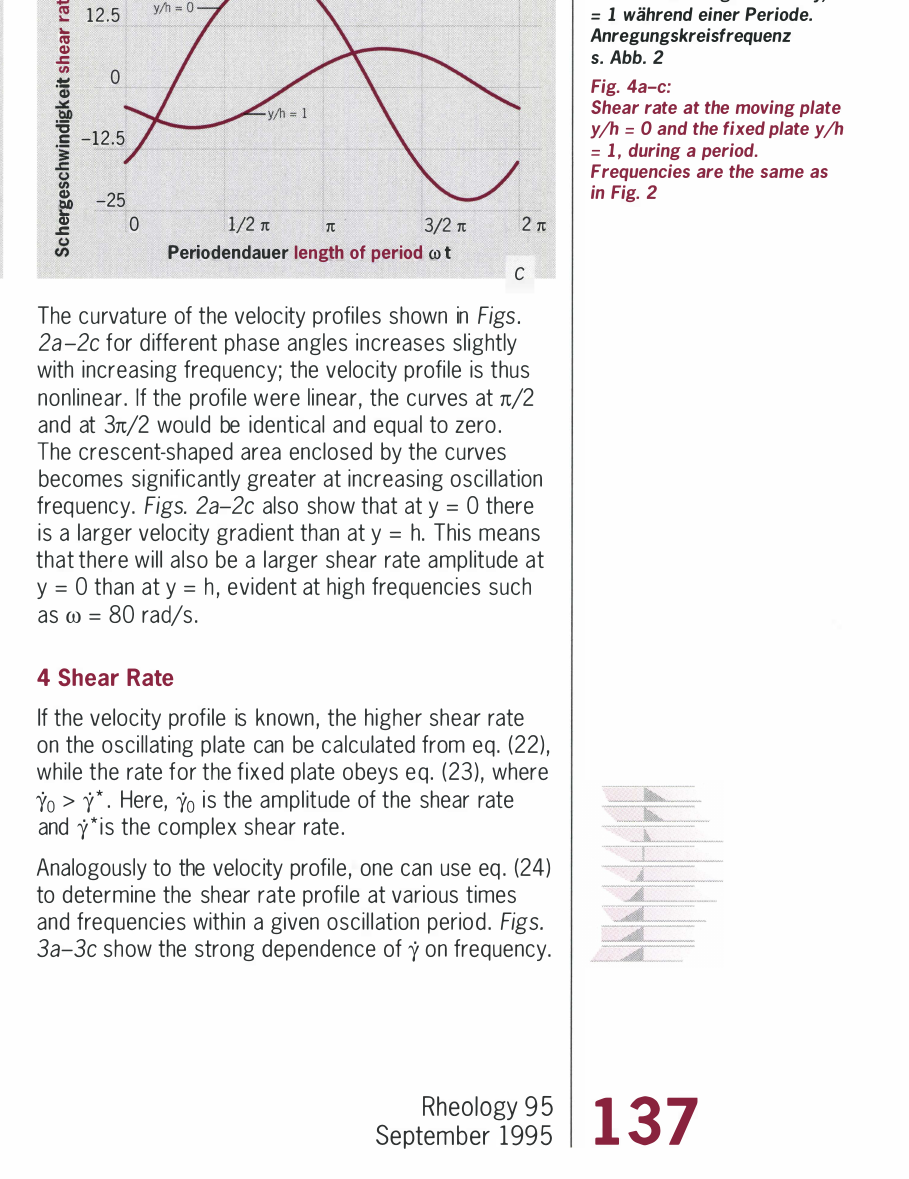
Fig. 3a-c: Shear rate profile 1 of glycerin with a gap h = 8 mm